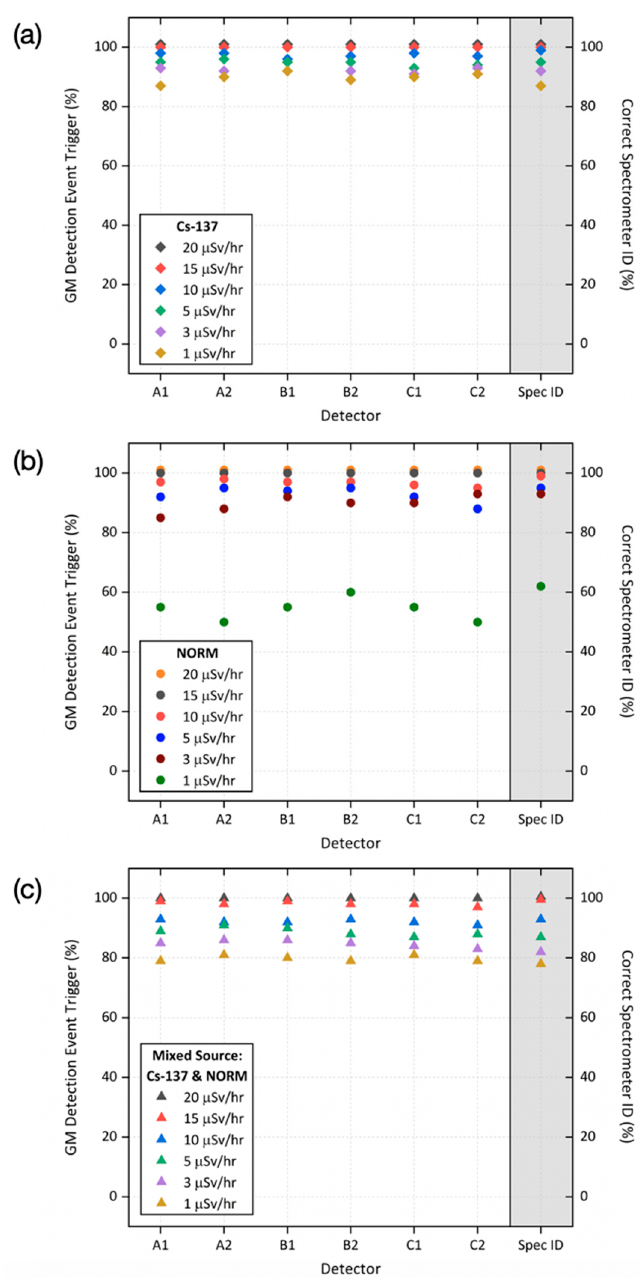
Figure 6. Sensitivity analysis of the integrated platform, detailing its ability to detect and spectrally identify sources of differing dose-rate (activity) levels, compositions and “on-person” positions, as detailed in Table 3, for sources of ( a ) Cs-137, ( b ) NORM and ( c ) mixed Cs-137 and NORM.